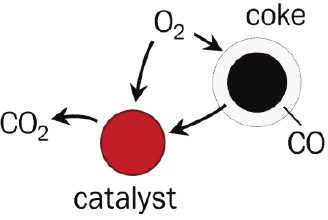
Figure 7. Scheme of coke gasification in a fluidized catalyst bed.